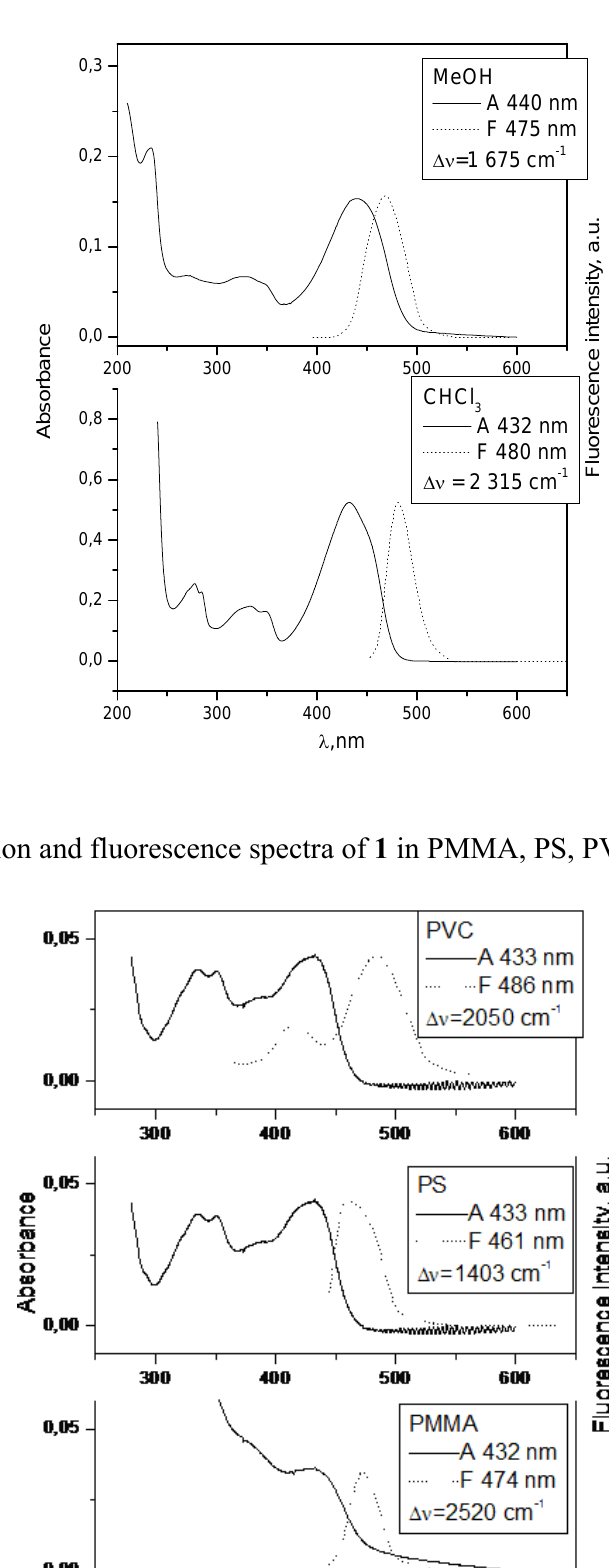
Figure 6 Absorption and fluorescence spectra of 1 in chloroform and methanol at 10 − 5 mol dm − 3 .